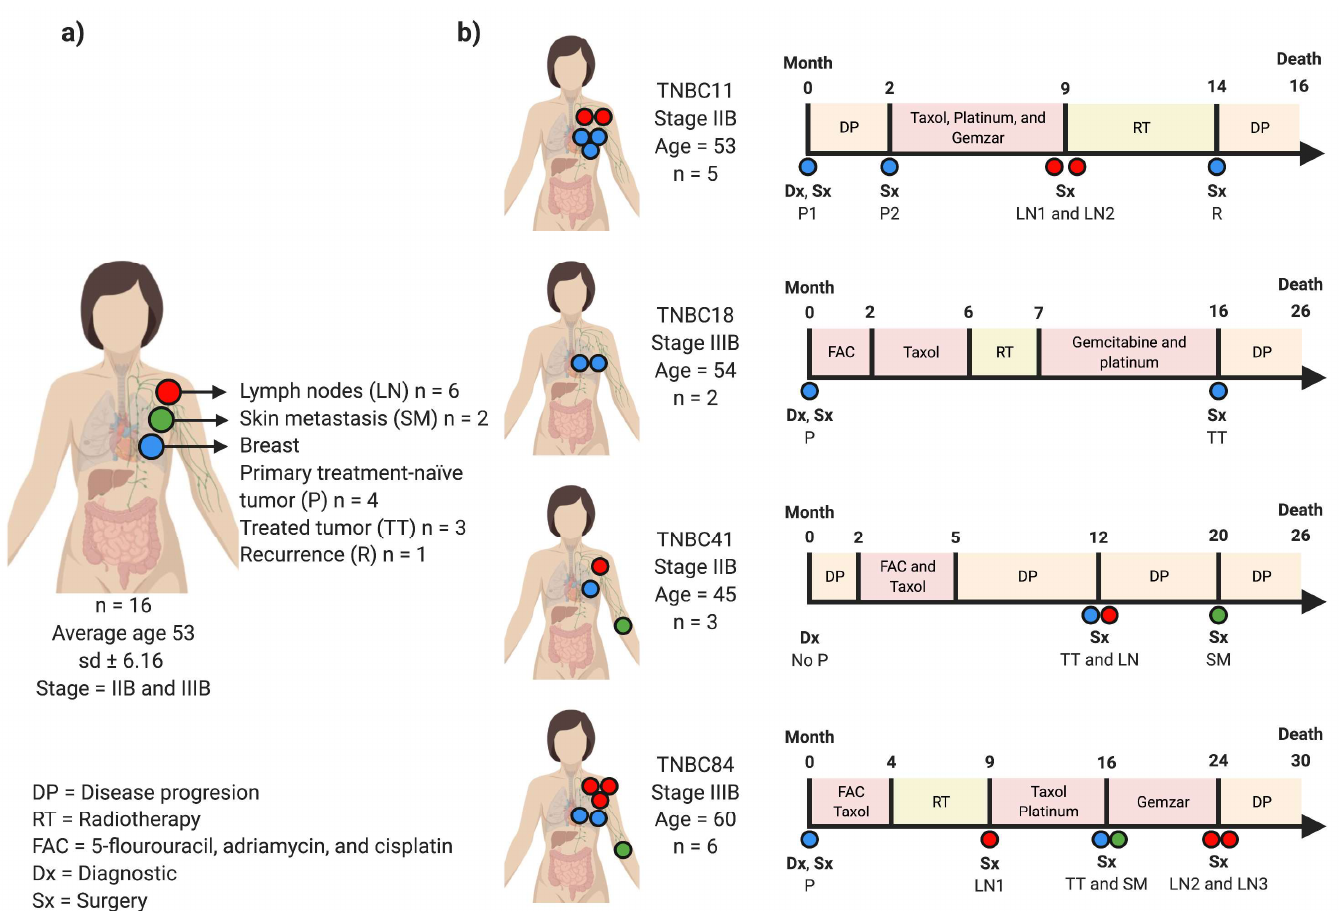
Figure 1. Clinical history of TNBC patients. ( a ) The cohort of TNBC with 16 samples from four patients includes tumors obtained before and after treatments, lymph node- and skin metastasis. ( b ) The timeline depicts the clinical characteristics of all patients analyzed and samples taken during the progression of the disease. Colored boxes show the different treatments received by patients (blue: breast; red: lymph node metastases; green: skin